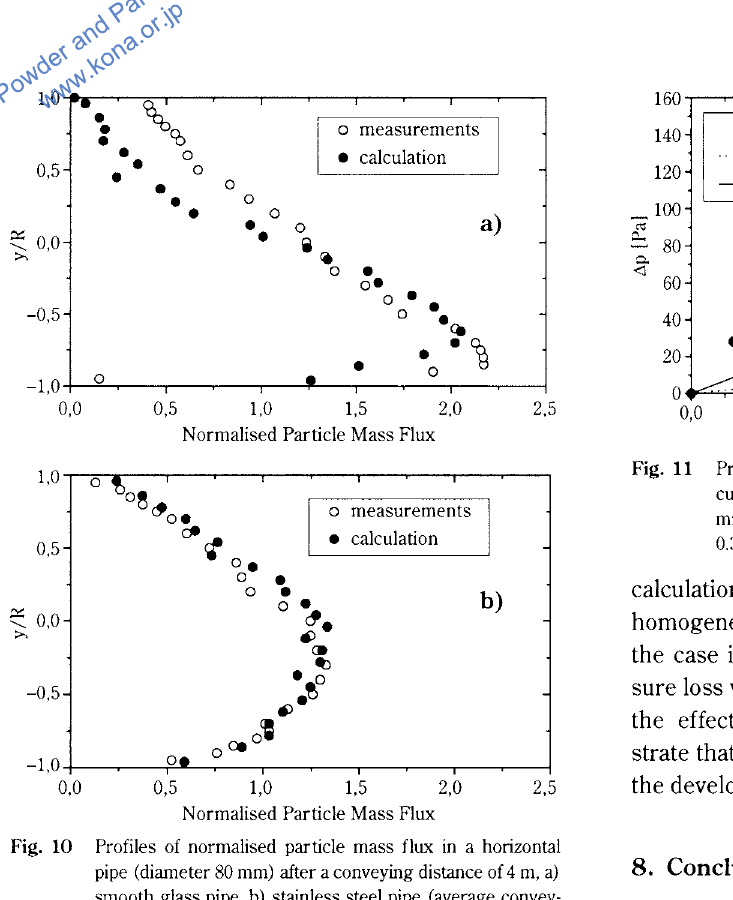
Fig. 10 Profiles of normalised particle mass flux in a horizontal pipe (diameter 80 mm) after a conveying distance of 4 m, a) smooth glass pipe, b) stainless steel pipe (average convey